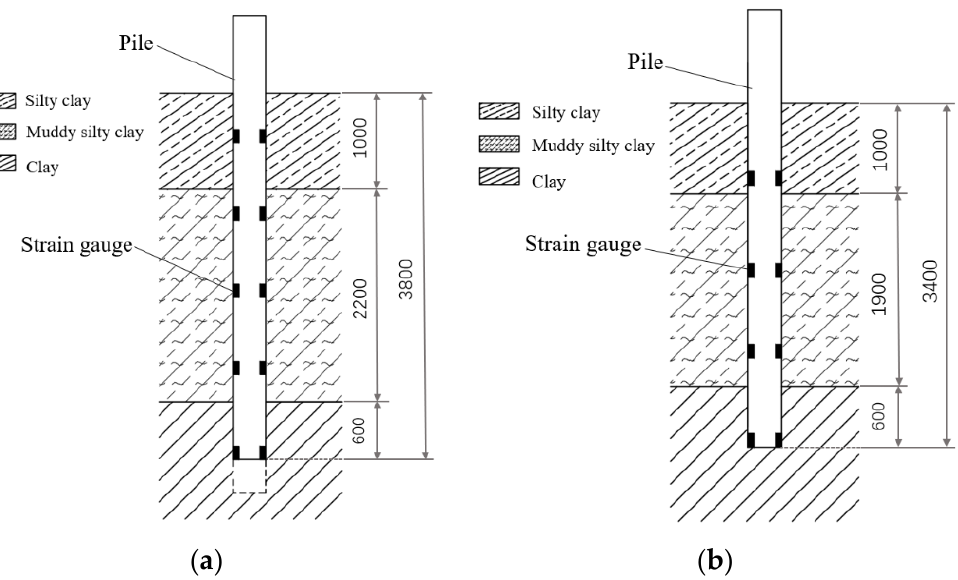
Figure 1. Schematic diagram of the position of the strain gauge in the test pile: ( a ) the pile-end soilless compressive pile and ( b ) the conventional compressive pile.